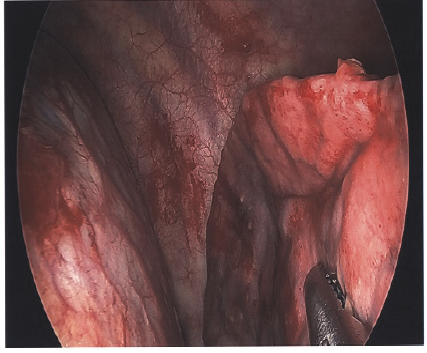
Figure 1: Images from VATS.